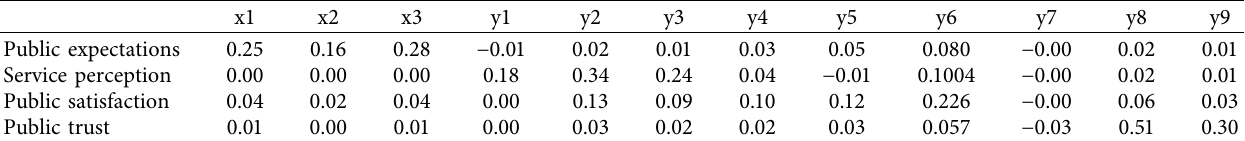
Table 13: Final factor weights.